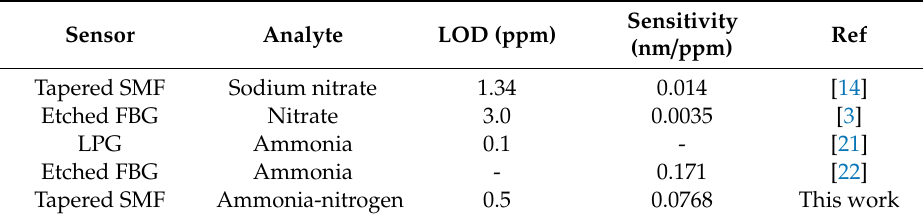
Table 1. Comparison between fabricated MFI sensor and other related sensors.